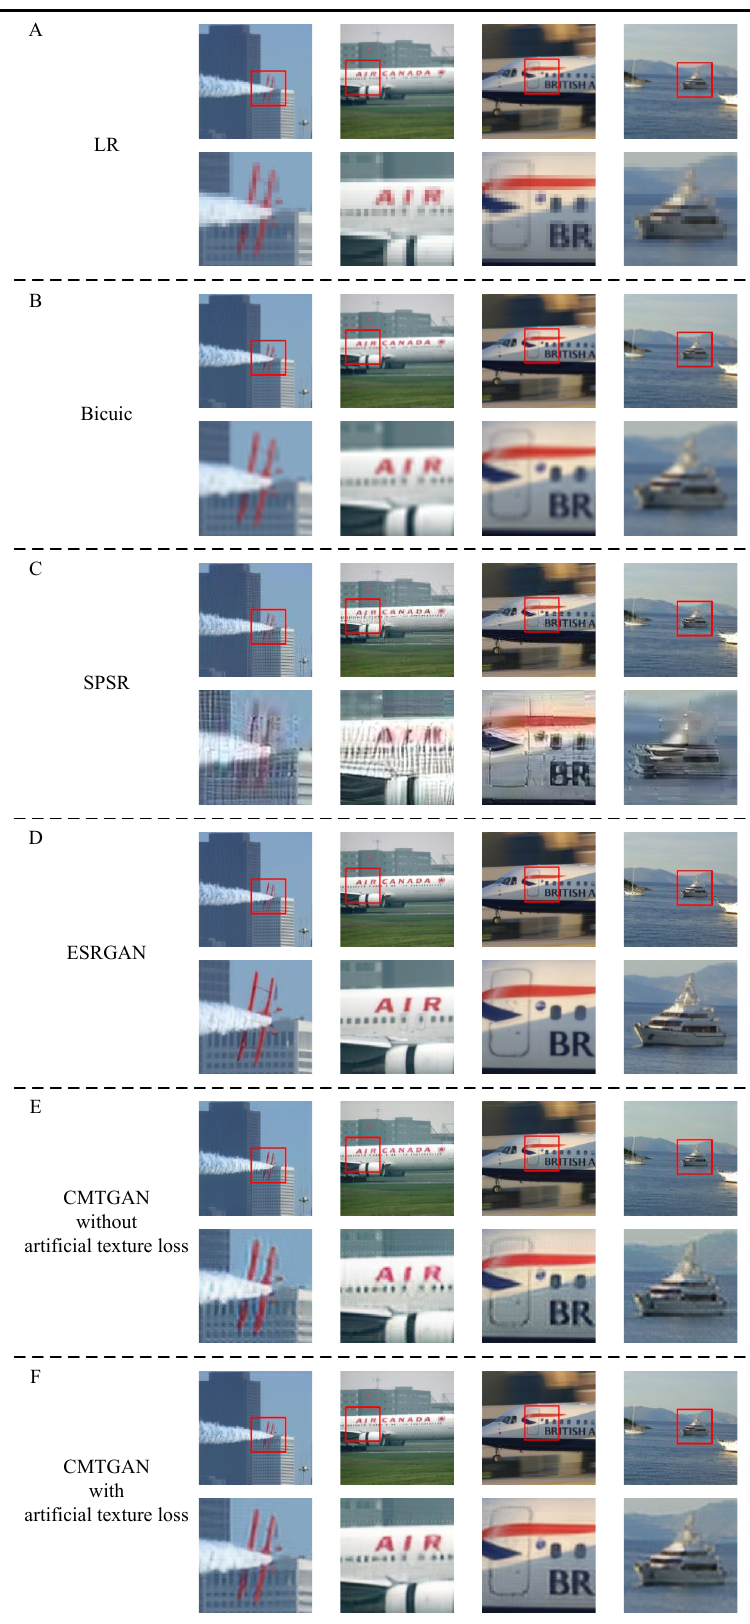
Figure 6. Performance of traditional interpolation methods and CNN-based